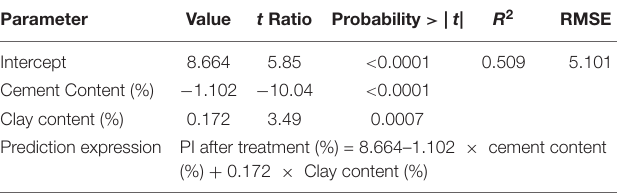
TABLE 3 | Multi-variate analysis results to predict PI after cement stabilization.